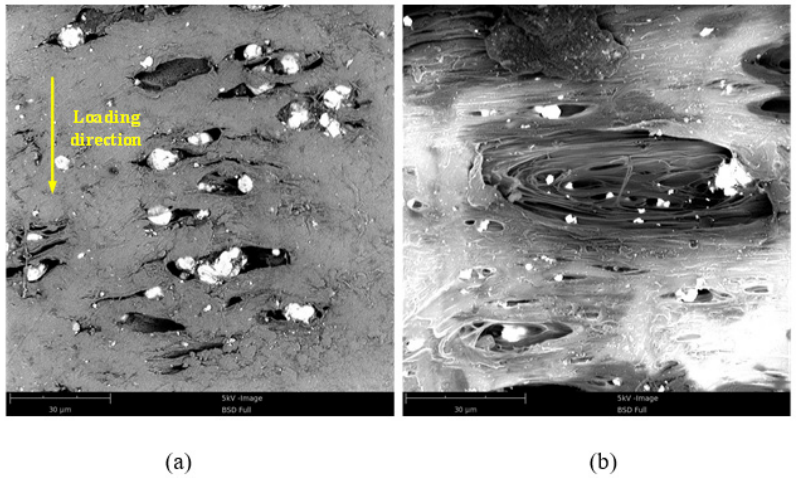
Figure 8. Micromorphology of the surface of specimen after compression: ( a ) PTFE-based RMs; ( b ) THV-based RMs. The surface is the lateral surface of the sample.